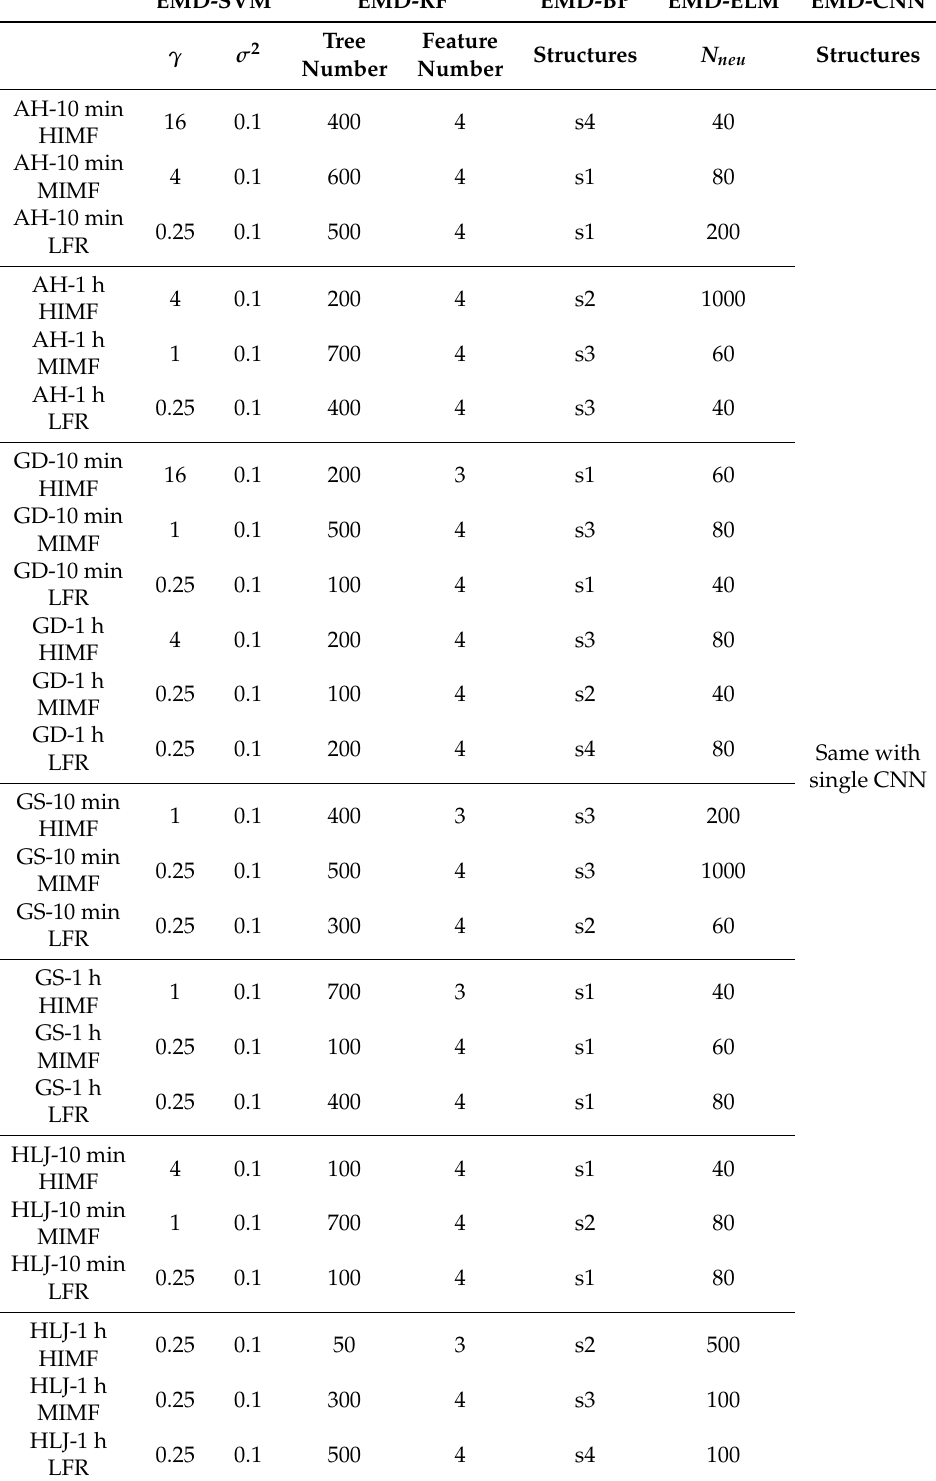
Table 10. Parameter selection results for single nonlinear models with EMD. EMD-SVM EMD-RF EMD-BP EMD-ELM EMD-CNN Tree Feature Structures N neu γ σ 2 Number Number